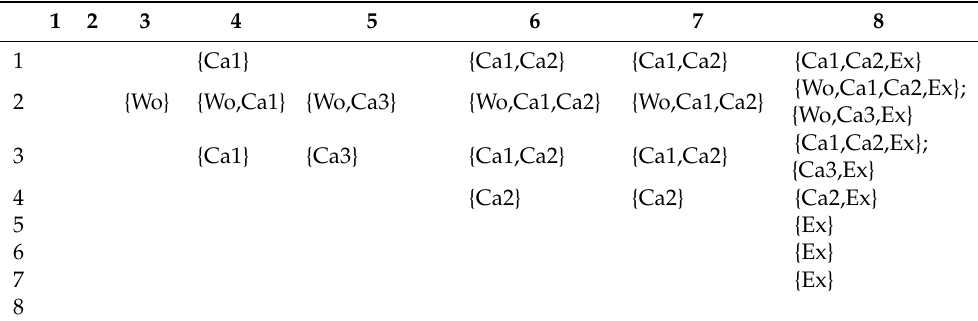
Table 3. Transition matrix defined on the basis of the f-HINe reported in the left part of Figure